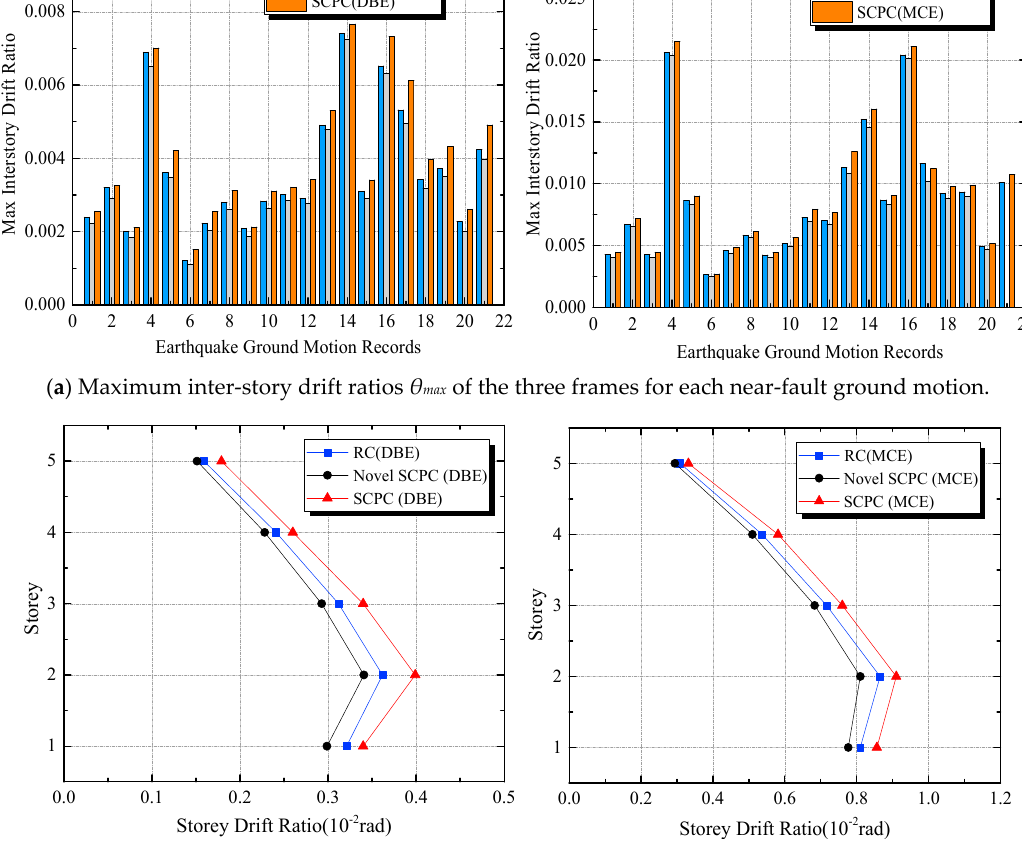
( b ) Maximum inter-story drift ratios θ max of the three frames for each story. Figure 24. Maximum inter-story drift ratios of three frames at DBE and MCE level.